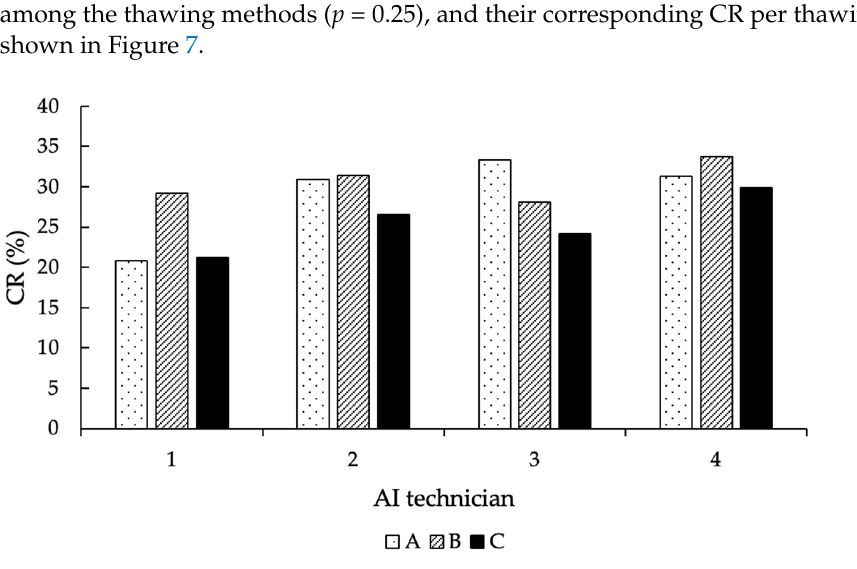
Table 5. Results of the first step of the GLMM with the inclusion of the random effect.